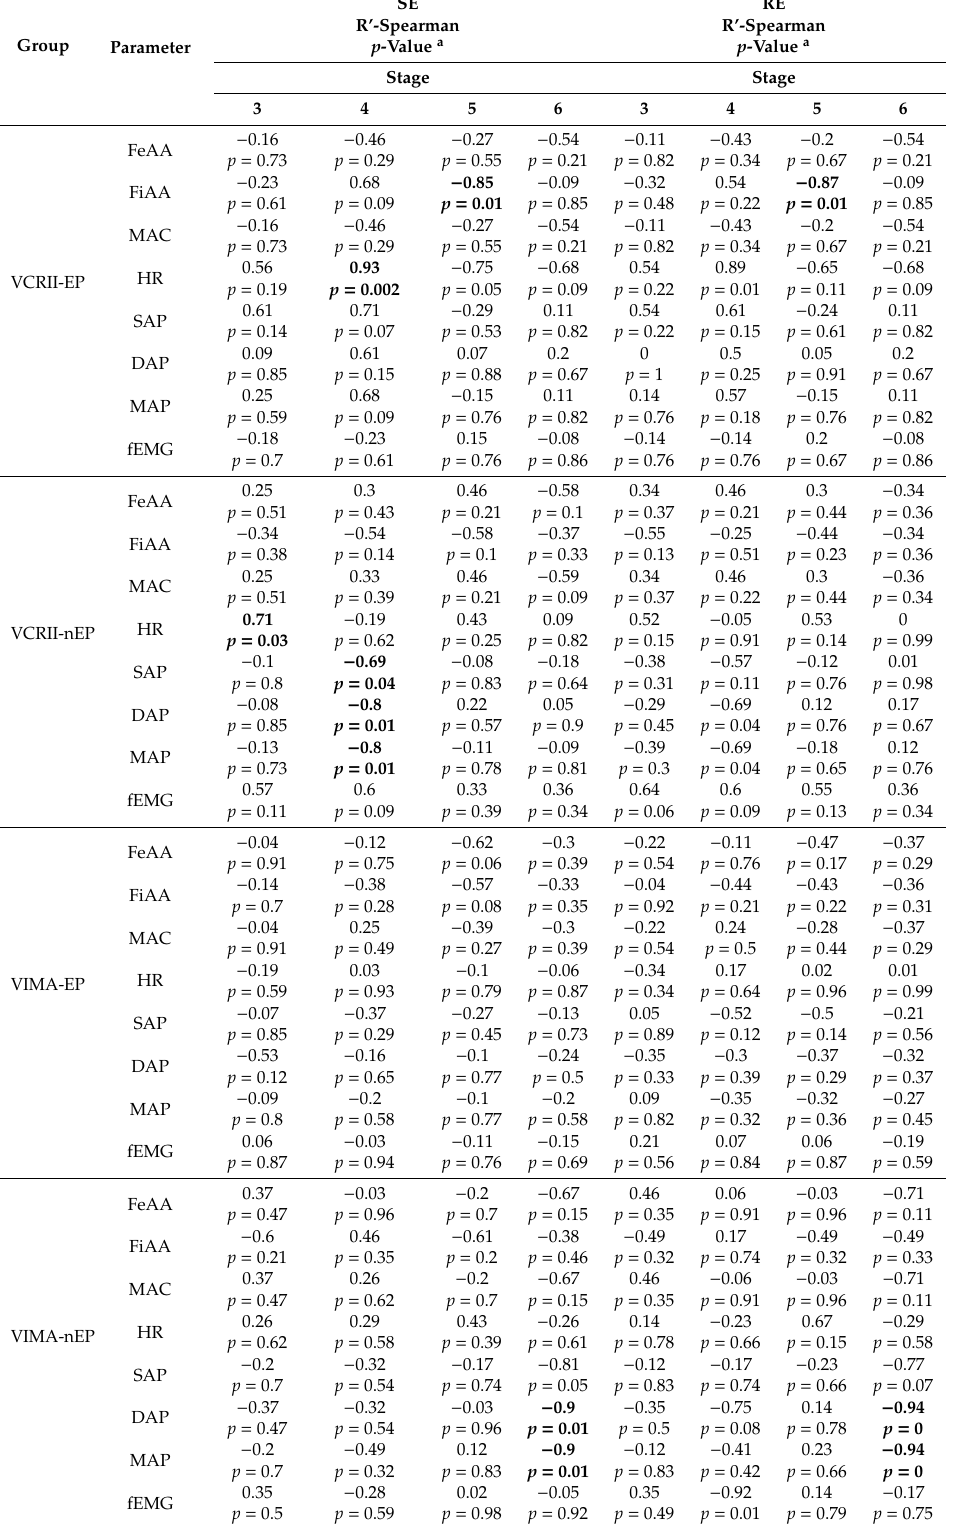
Table 3. The strength of the relationship between selected parameters. R’ Spearman’s correlation coefficient.